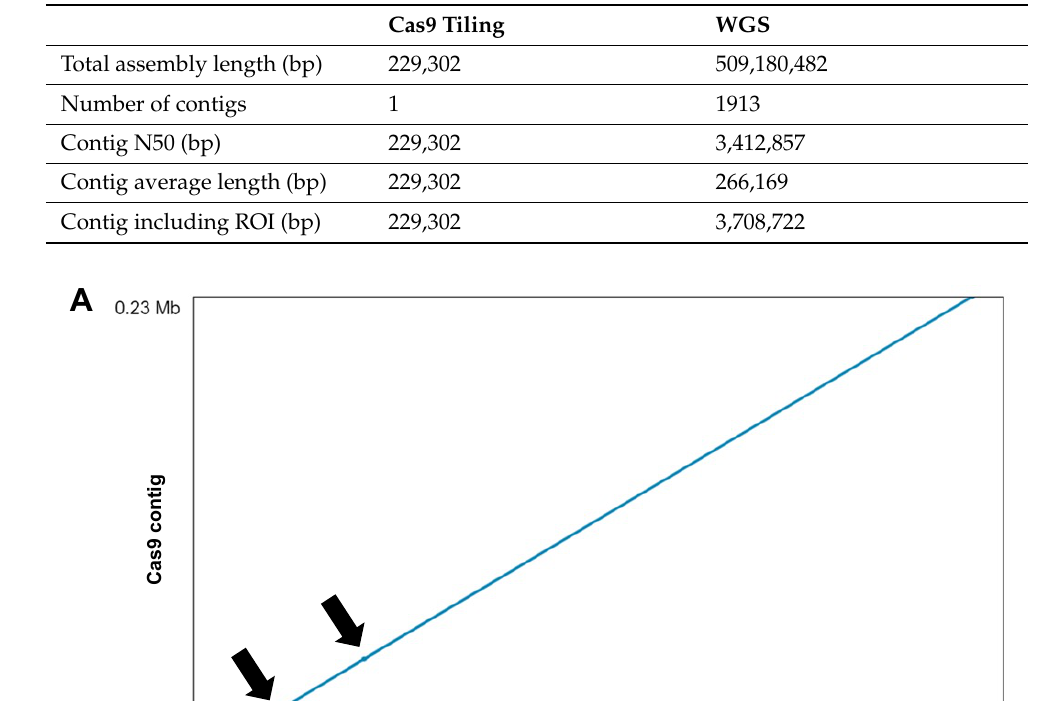
Table 3. ONT assembly statistics, comparing Cas9 tiling and whole genome sequencing (WGS).